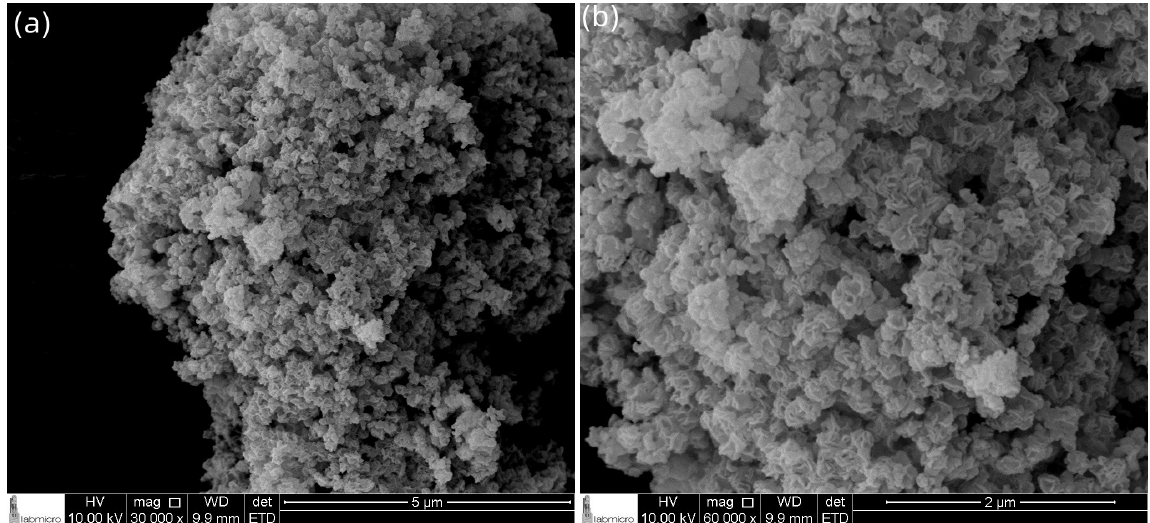
Figure 3. SEM Photomicrographs of synthesized NAS clay ( a ) 30,000 × and ( b ) 60,000 ×